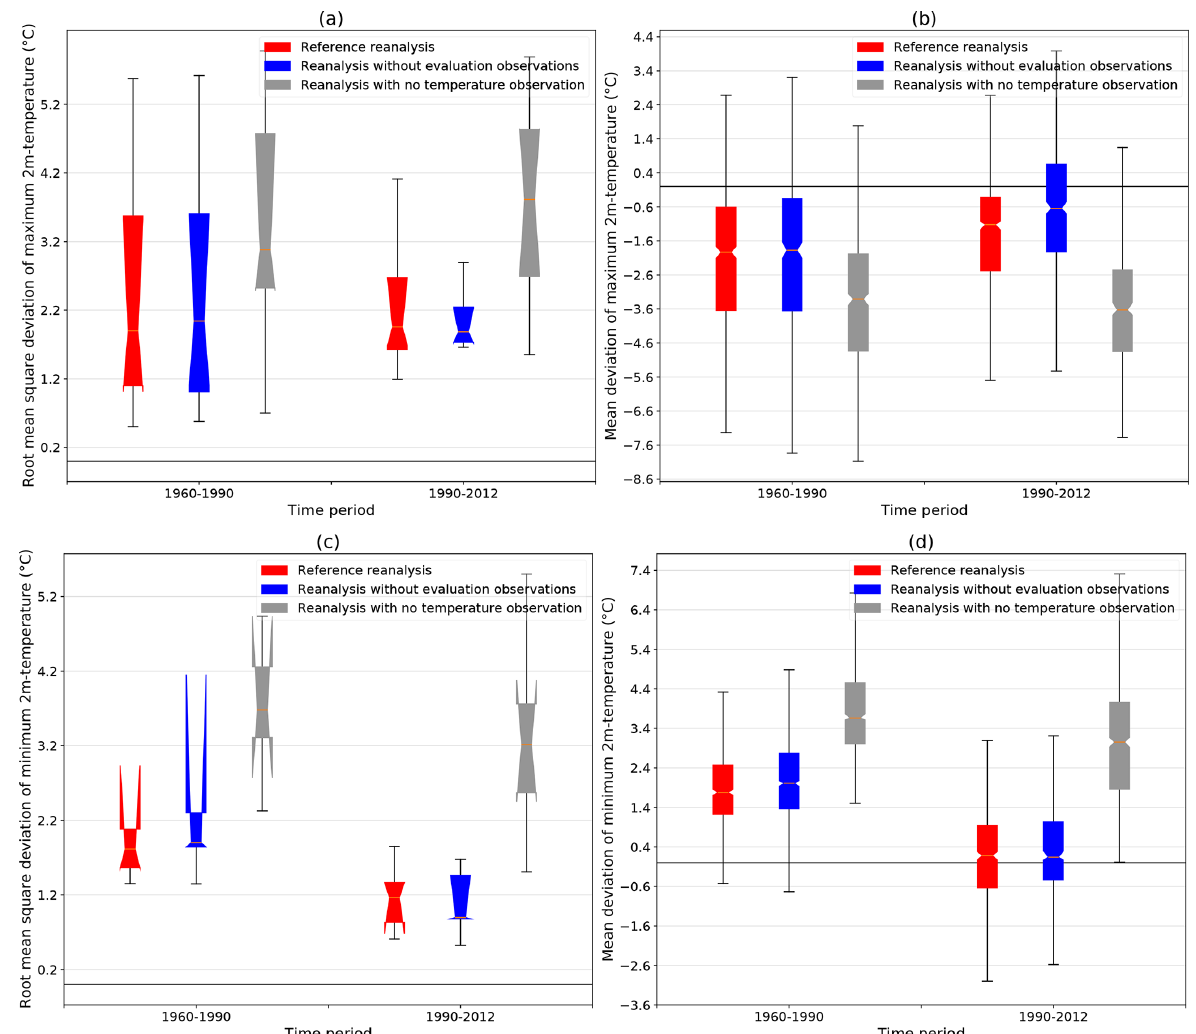
Figure B2. Same as Fig. 10 but for summer (JJA) 2m temperatures